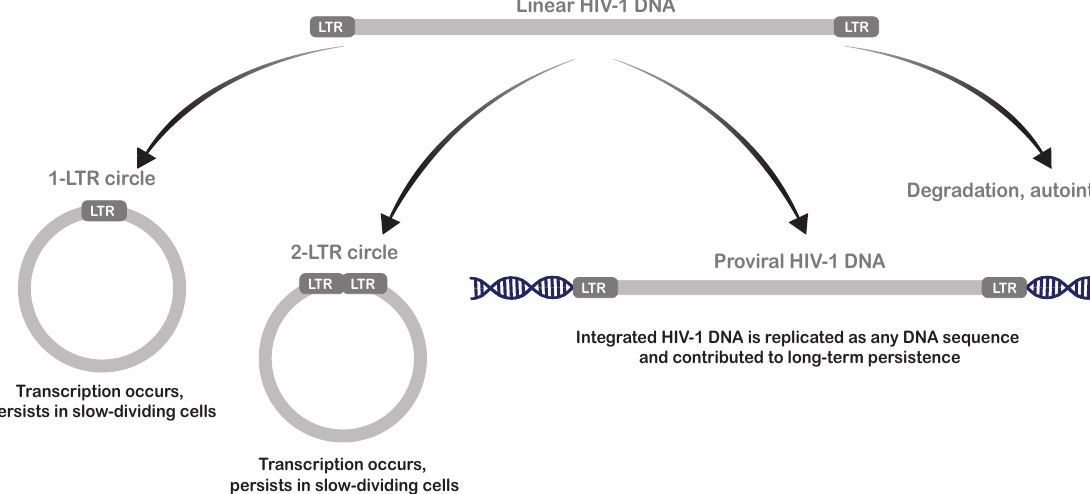
Figure 1. Fates of unintegrated HIV-1 DNA and respective contribution to viral persistence. Adapted from [38]. Following retrotranscription, the nuclear linear HIV-1 DNA can be integrated into the host genome as a provirus, can be degraded or can recombine or exploit host DNA repair machinery to generate functional 1-LTR or 2-LTR episomal circles from which transcription